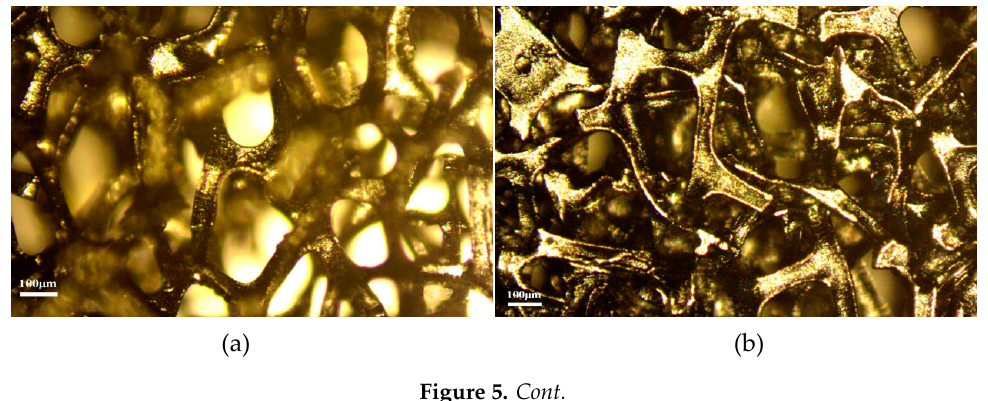
Figure 4. ( a ) ( b )Scanning electron microscope(SEM) image of 3DG; ( c )anode of CP; ( d )microporous layer of CP.